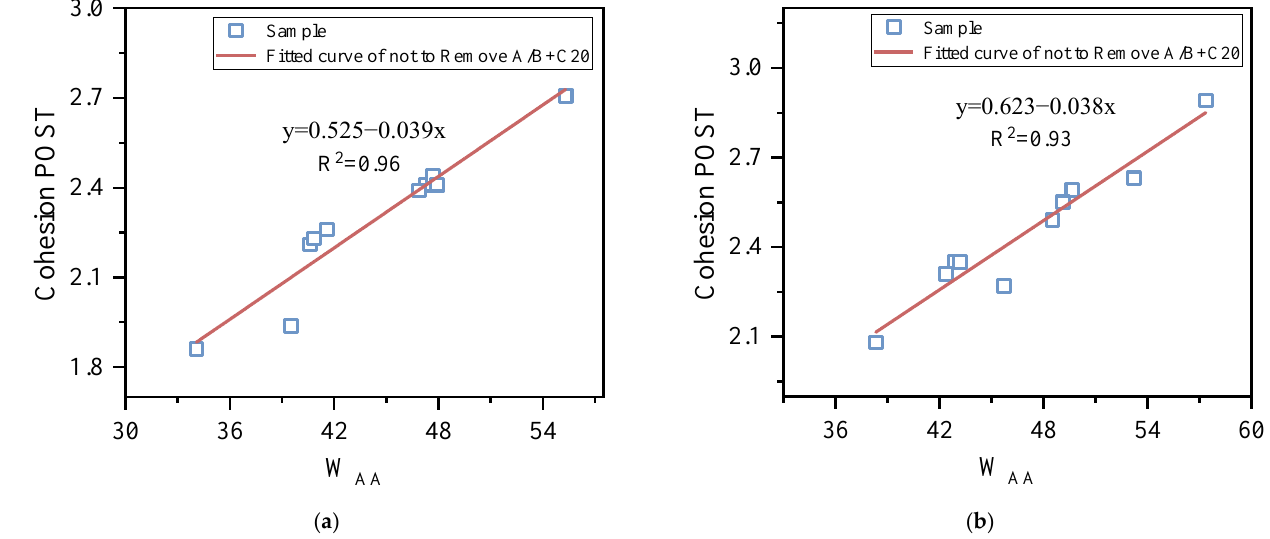
Figure 13. Correlation between cohesion POTS and cohesion work. ( a ) 1 h, ( b ) 168 h.